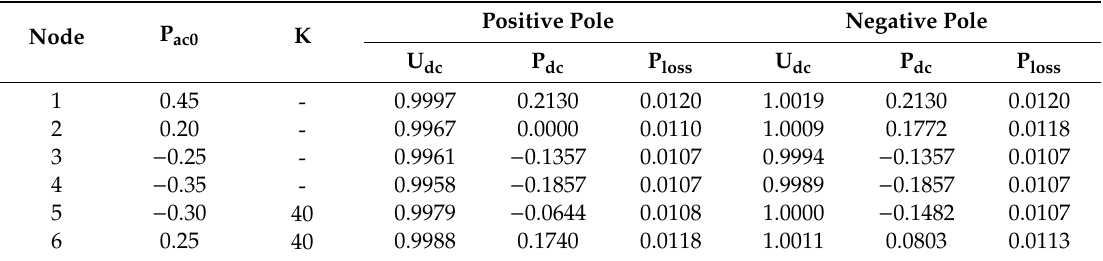
Table 5. Power flow calculation results with multi-point voltage control (p.u.).